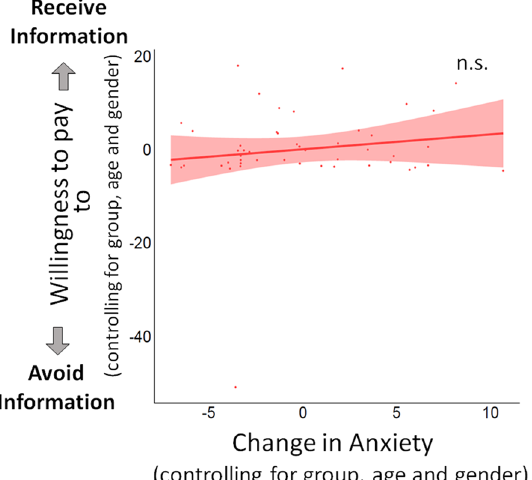
Figure 6. Change in anxiety was not related to willingness to pay for information (Study 2b). Plotted is the partial linear regressions predicting WTP (in pence, coded positively if participants indicated they wanted to receive information and negatively if they wanted to avoid information) from change in anxiety induced by the manipulation, controlling for age and gender (p = 0.437). Results did not change when removing the one